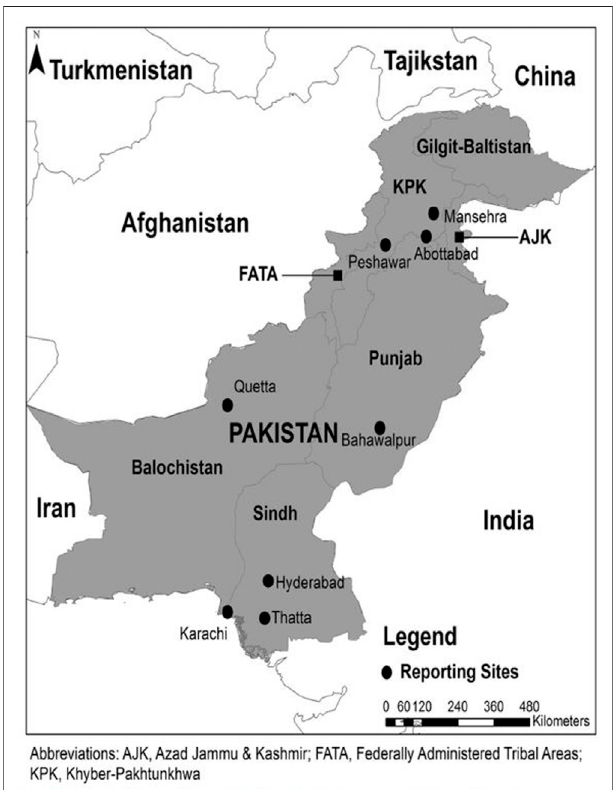
FIGURE2| MapofPakistanshowingthe fi vemajorprovincesandmajor cities; source: Kalwar, Dali, Hassan, (2018).